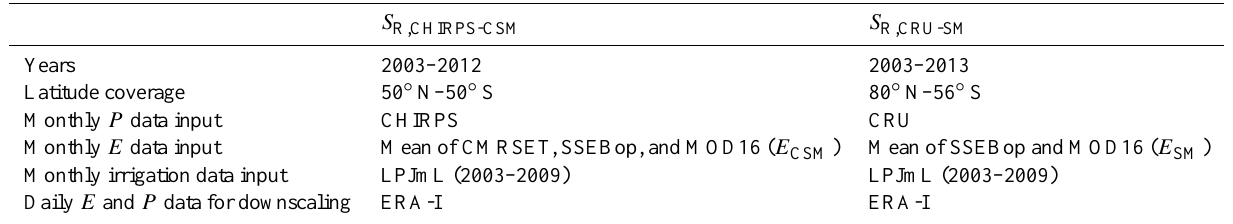
Table 1. Overview of the time period, latitudinal coverage, and data input for the two root zone storage capacity S R data sets ( S R,CHIRPS-CSM and S R,CRU-SM ) produced in this